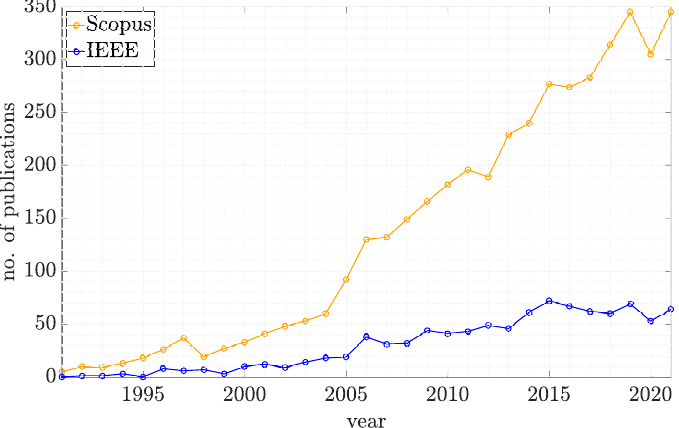
Figure 1. The pose estimation research space is saturated with variants or the usage of the Iterative Closest Point algorithm and continues to grow exponentially. The data was recorded by searching for the keywords iterative closest point in the title and/or abstract. The plot is adapted from [25]. Common methods for solving the point cloud-to-model registration problem are summarised in Table 1 and discussed below. Table 1. Summary of point cloud-to-model registration